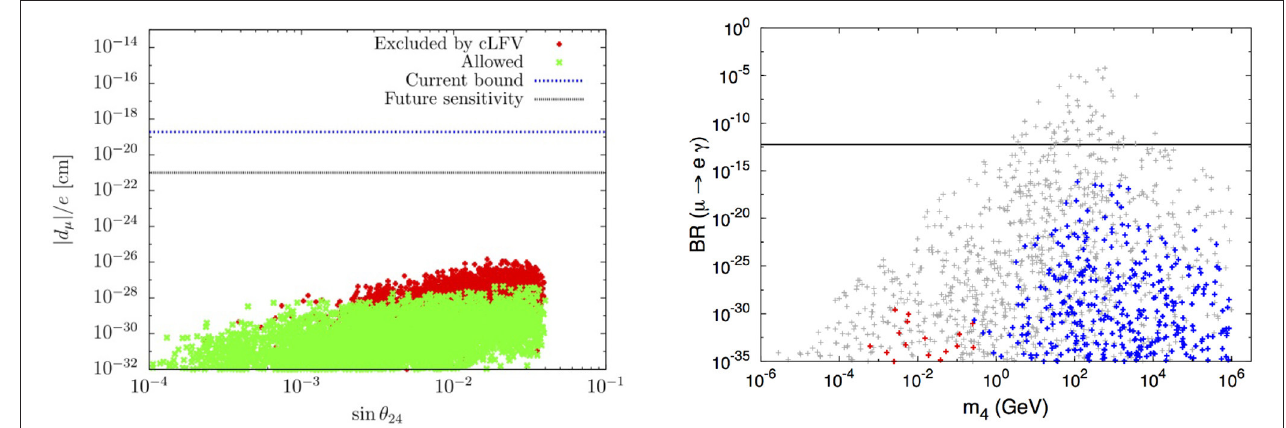
FIGURE 2 | Contributions to the muon EDM in a “3 2” model as a function of θ 24 (left panel) ; blue and black lines respectively denote the current upper bounds + e γ ) as a function of m 4 ; gray points correspond and future experimental sensitivity. From [21], reproduced with permission from the Authors. On the (right) , BR( µ → to the violation of at least one experimental bound and the horizontal line the current MEG bound.